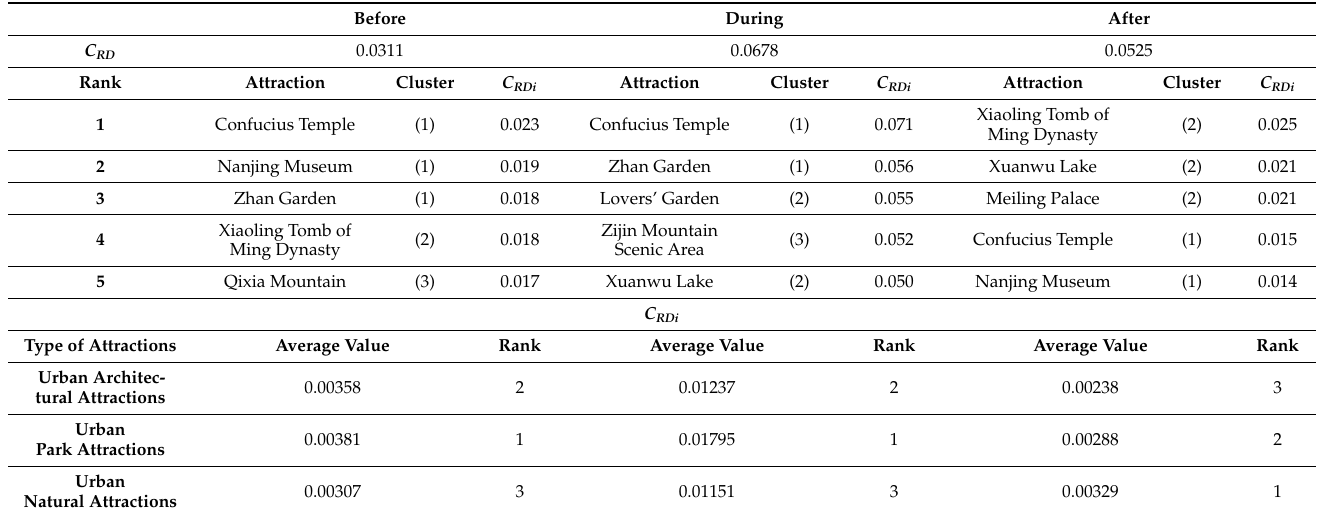
Table 5. Network and node degree